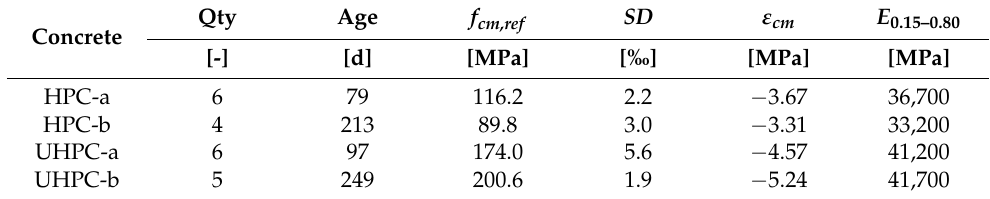
Figure 3. Stress–strain curves of HPC and UHPC per concrete batch (max. and min. curves). Table 5. Mean values of the fatigue reference compressive strength, ultimate strain and